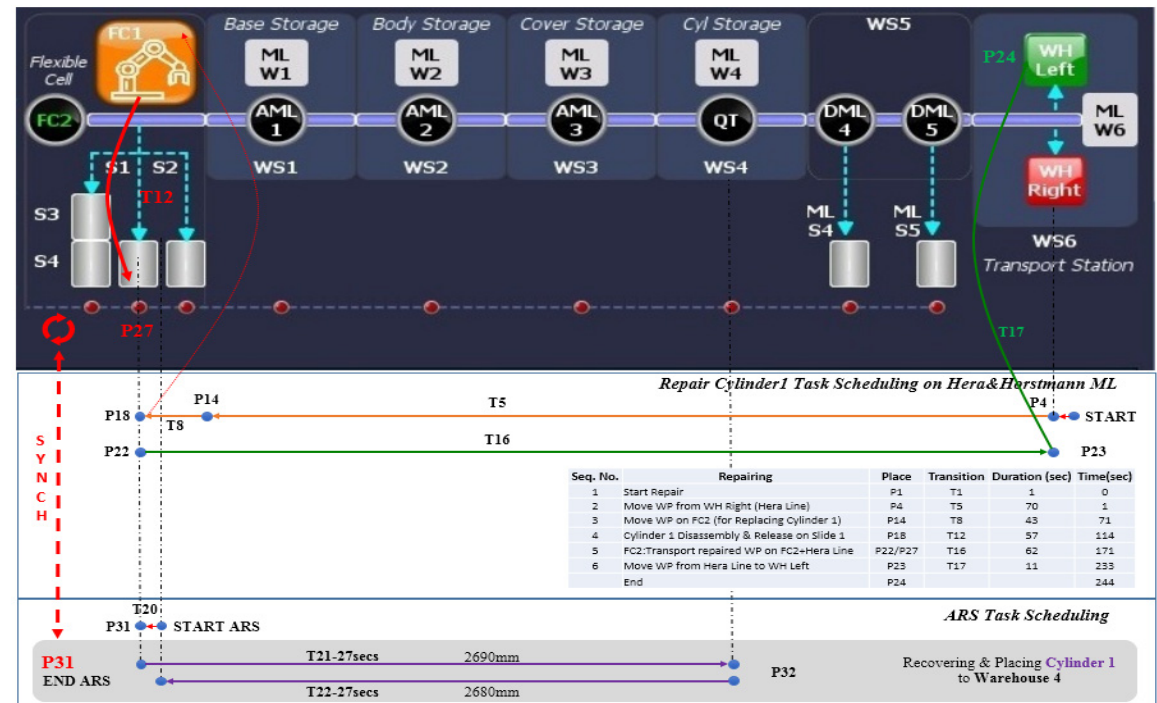
Figure 16. ARS task scheduling for disassembly operation.